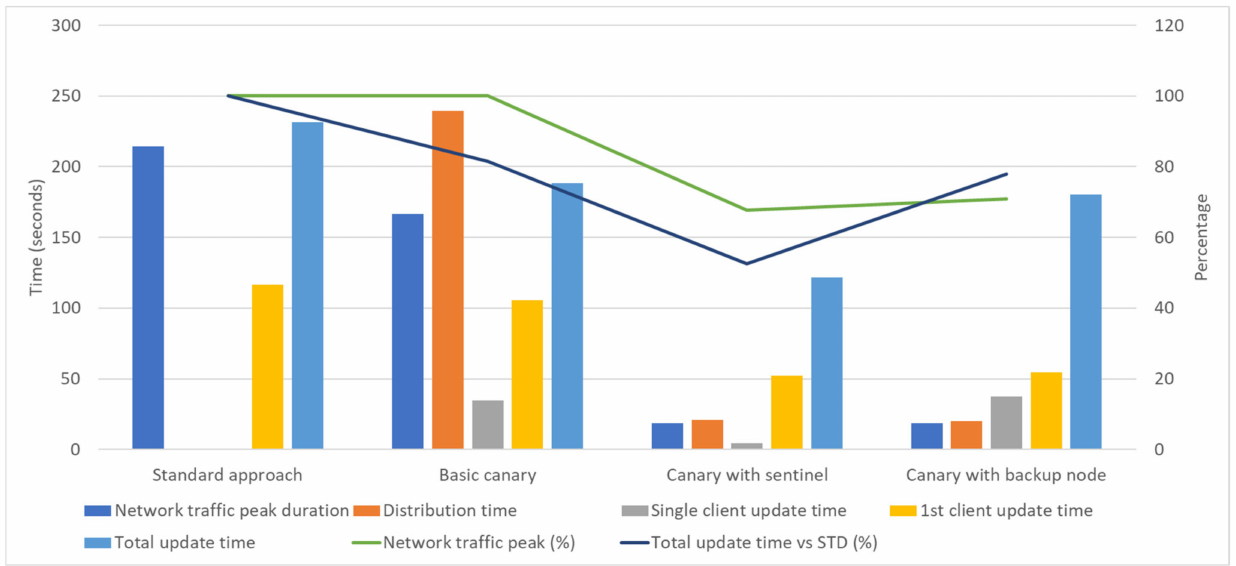
Figure 15. Comparison of time needed for various stages of the client update